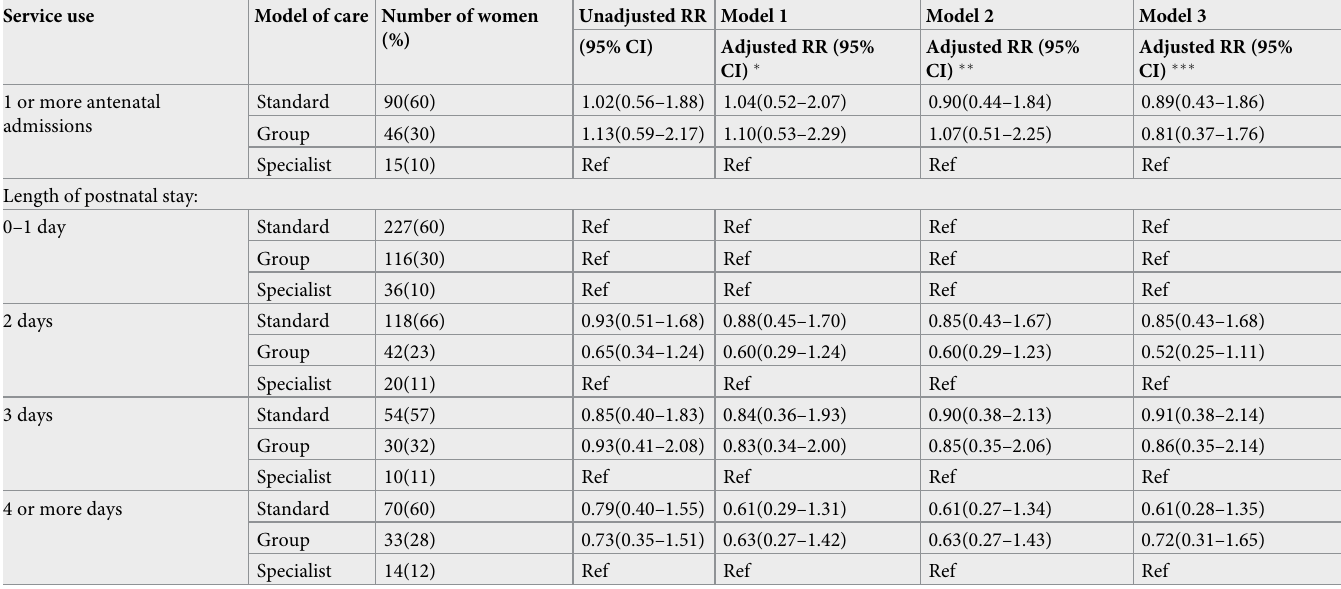
Table 14. Women’s service use in relation to the model of care received.